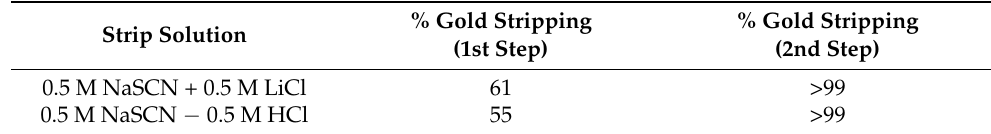
Table 7. Gold stripping after two steps.